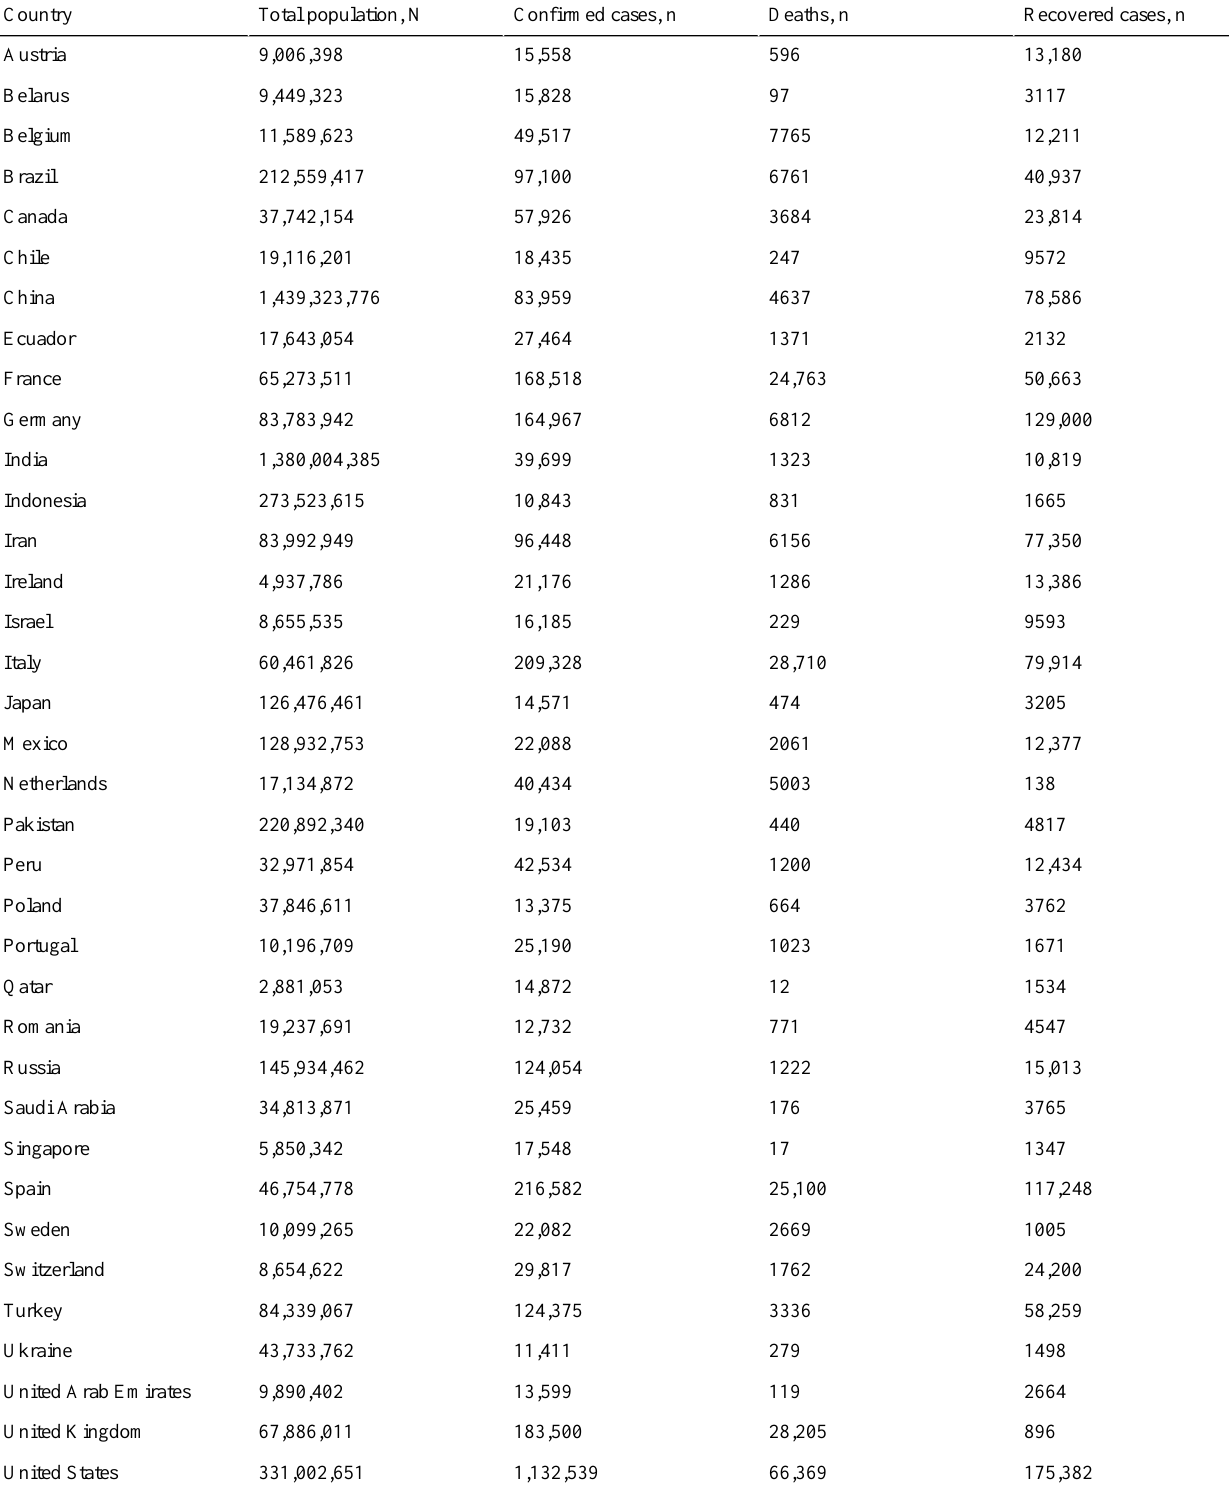
Table 1. Total population and the total number of confirmed cases, death cases, and recovered cases for countries that reported at least 10,000 confirmed cases by May 2,